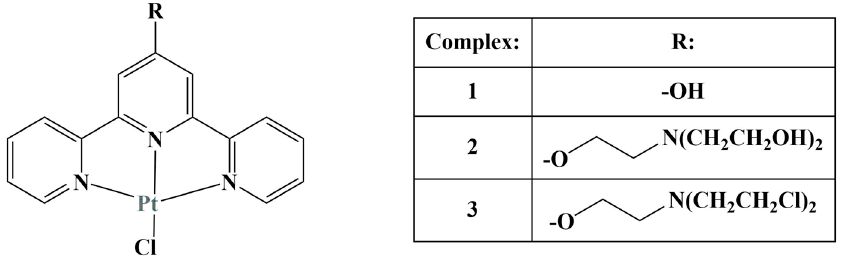
Figure 3. Three Pt(II)-terpyridine complexes, described in [25].